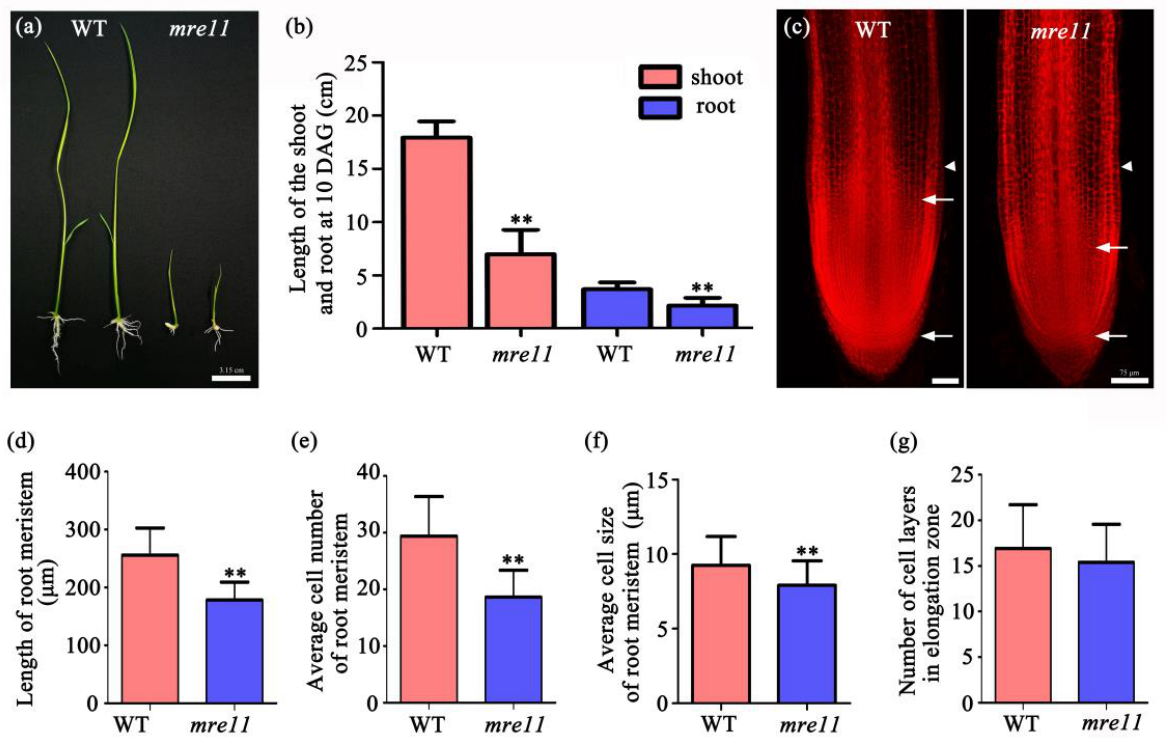
Figure 4. Characteristics of roots in WT (Wild-type) and the mre11 mutant of rice. Characteristics of roots in WT and the mre11 mutant of rice. ( a ) The phenotypes of 10-day-old WT and the mre11 seedlings. Scale bar represents 3.15 cm. ( b ) Shoot (red) and root (blue) length of 10-day-old WT and the mre11 . The numbers of WT and the mre11 were 40 and 14, respectively. ( c ) Phenotype characteristics of root apical meristem in the WT and the mre11 of rice. The two arrows indicated the areas of root apical meristem. The two arrowhead in each root showed the location of counting cell layers from outside to inside in elongation zone of the root tip. Scale bars represent 75 µm. ( d ) The analysis in length of root apical meristem. ( e ) Average cell number of root apical meristem. ( f ) Average cell size of root apical meristem. ( g ) Number of cell layers from outside to inside in root elongation zone. ( d – g ) The numbers of WT and the mre11 are 37 and 31, respectively. The two asterisks represent a statistically significant di fference according to Student’s t -test (**, p < 0.01).